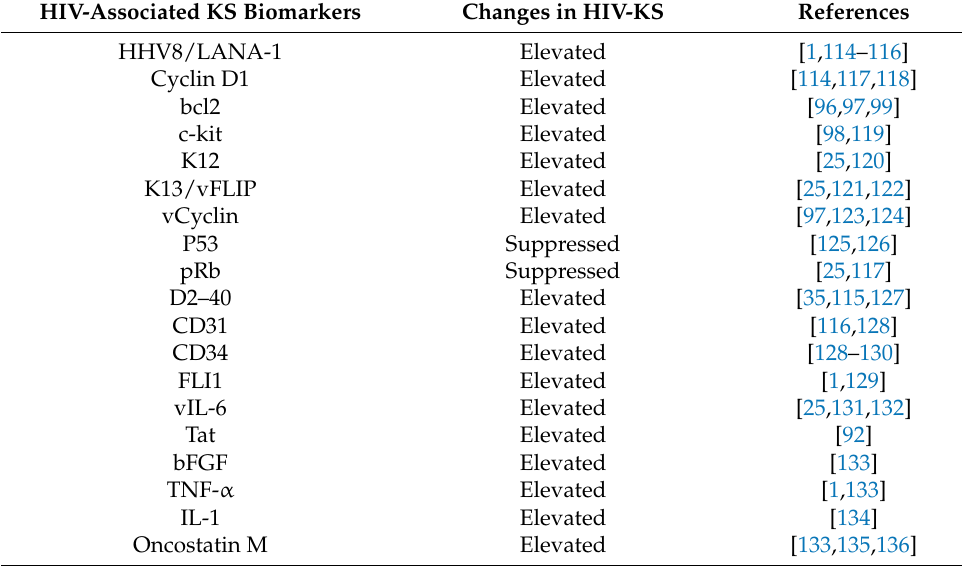
Table 3. Identified biomarkers and the related changes in HIV-associated Kaposi’s Sarcoma. HIV-Associated KS